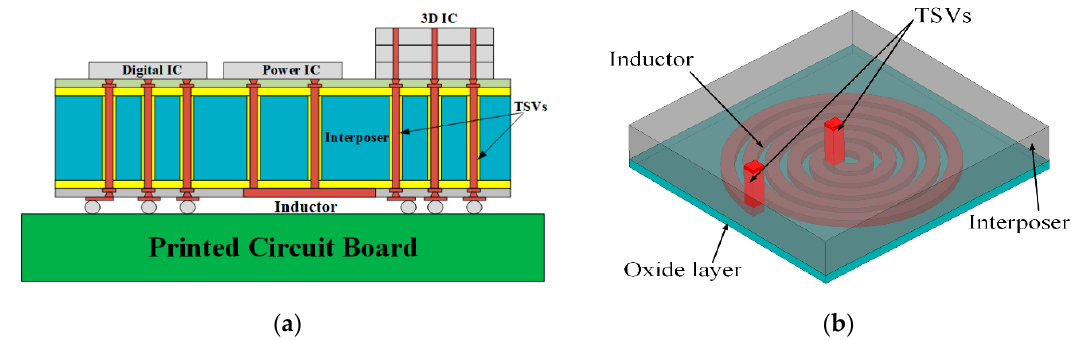
Figure 1. Schematic of ( a ) the 3D IC package and ( b ) the 3D view of the proposed backside integrated power inductor.